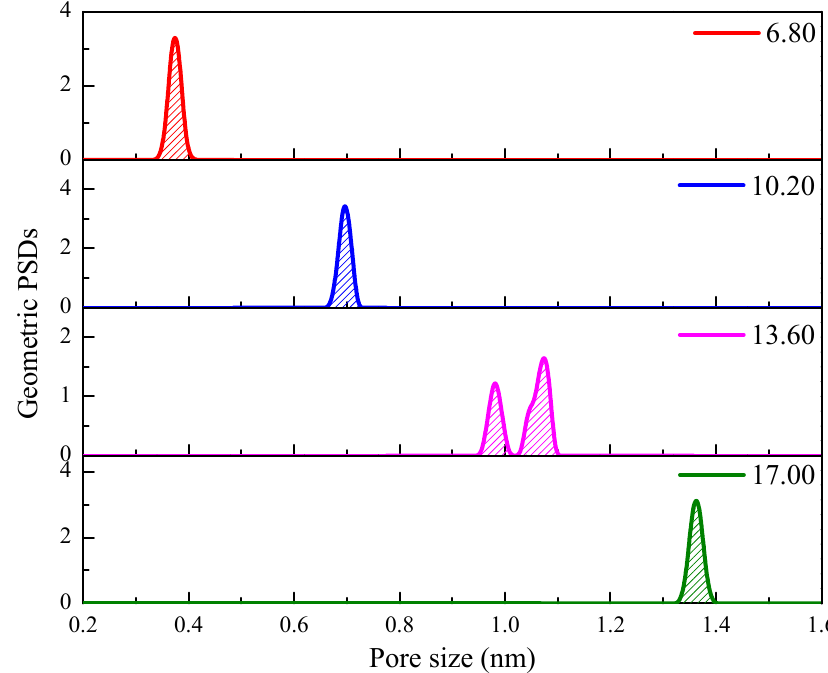
Figure 2. Pore size distributions of N-MGN with different interlayer distance.